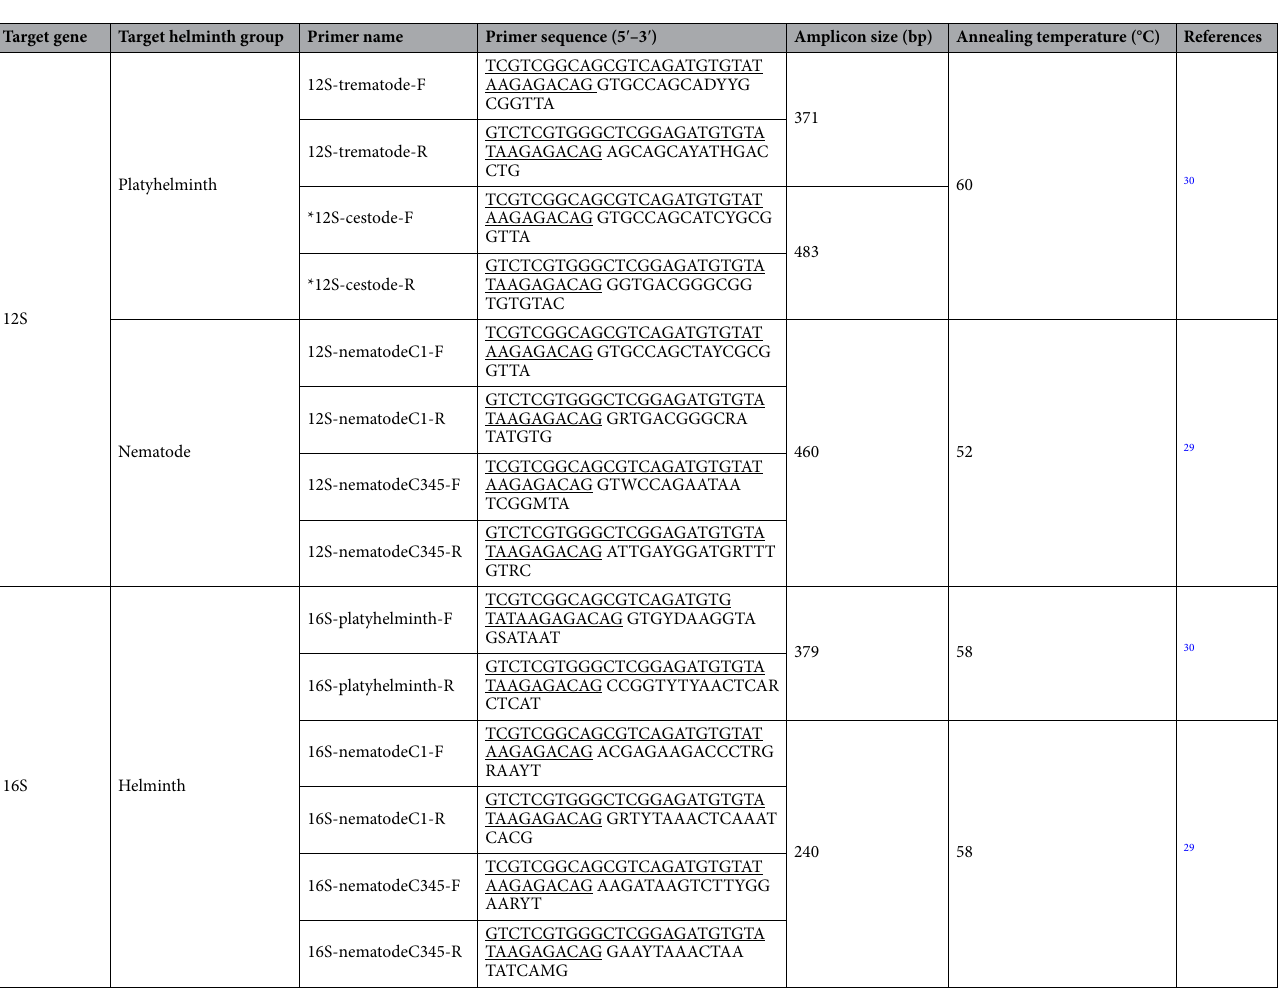
Table 2. 12S and 16S rRNA gene primer sequences targeting each helminth group and their respective annealing temperatures. *Indicates newly designed primers in this study. The Illumina overhang adaptor sequences are